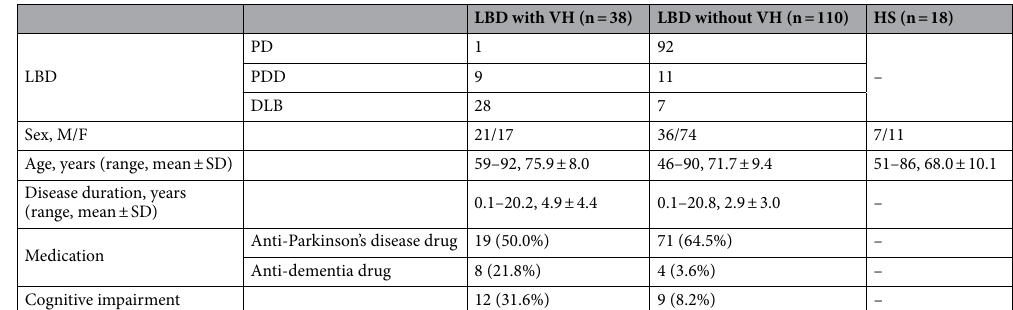
Table 1. Demographic and clinical data of the subjects. LBD Lewy body disease, VH visual hallucination, HS healthy subject(s), PD Parkinson’s disease, PDD Parkinson’s disease with dementia, DLB dementia with Lewy’s bodies, M male, F female, SD standard